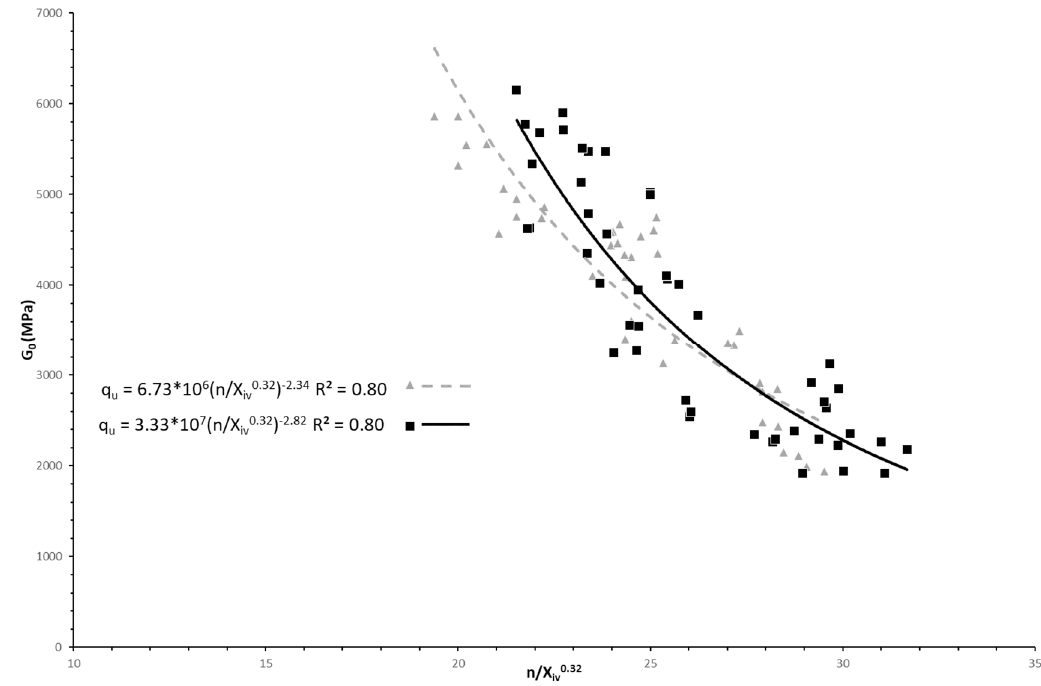
Figure 9. Variation of initial shear modulus (G 0 ) with adjusted porosity / binder index for all blends, considering cement + 5% wood-ash and cement + 10% wood-ash.